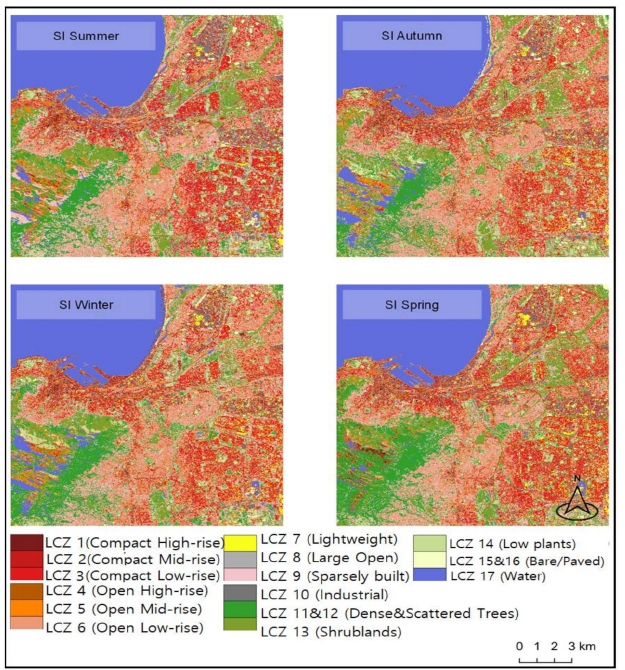
Figure 8. Cape Town single image classifications across all 4 seasons with standard training according to WUDAPT